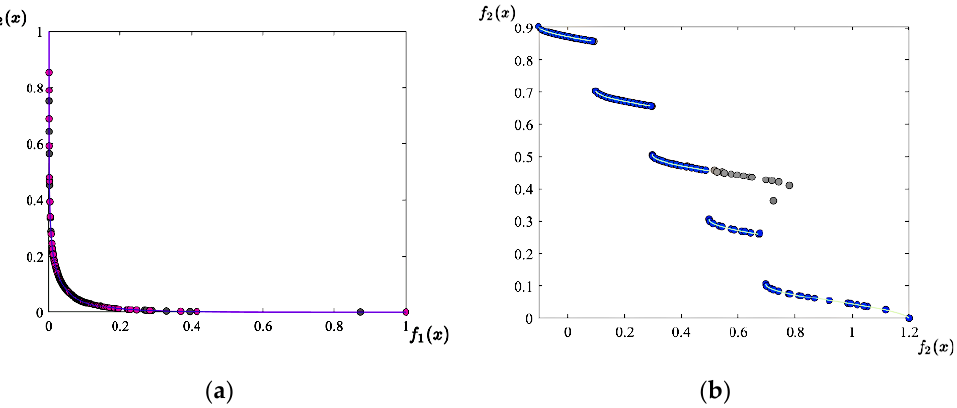
Figure 1. Comparison of MOEA/D-AWA and M-E-AWA on complex datasets. (( a ) Comparison of MOEA/D-AWA and M-E-AWA on IOMP1. ( b ) Comparison of MOEA/D-AWA and M-E-AWA on IMOP2).